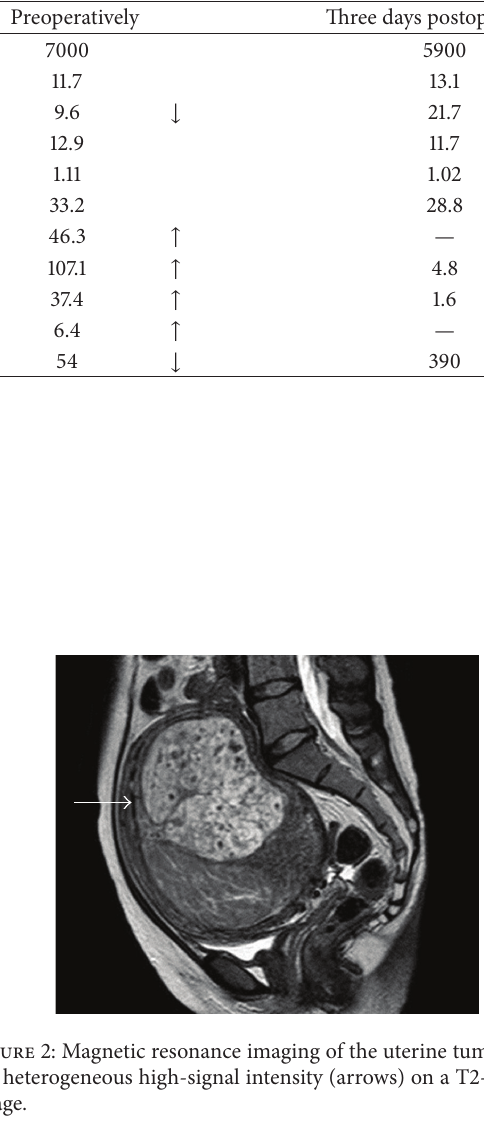
Table 1: Preoperative and postoperative examination data.